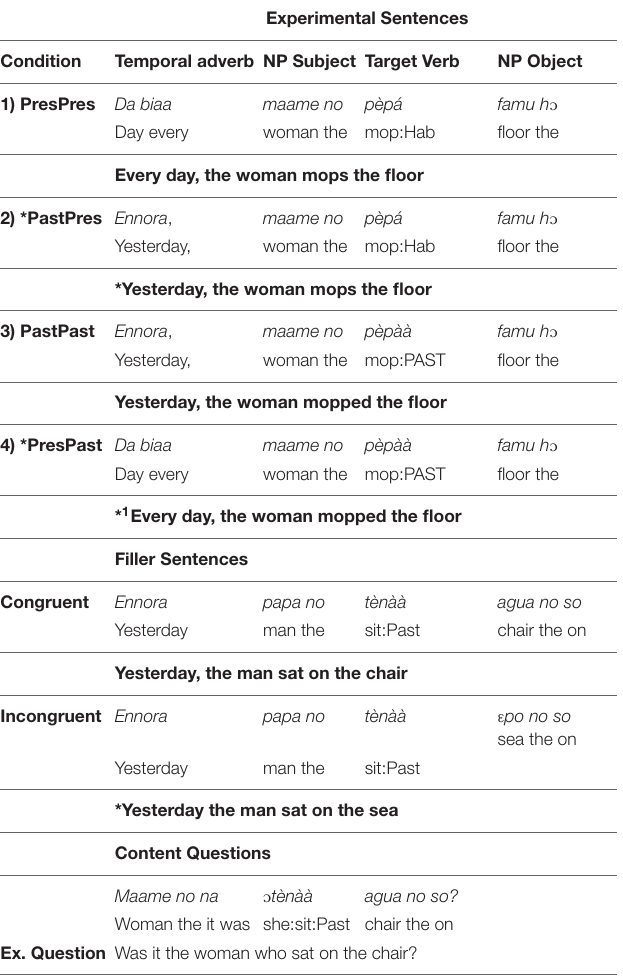
TABLE 1 | Examples of experimental sentences, filler sentences and content questions used in the experiment. Experimental